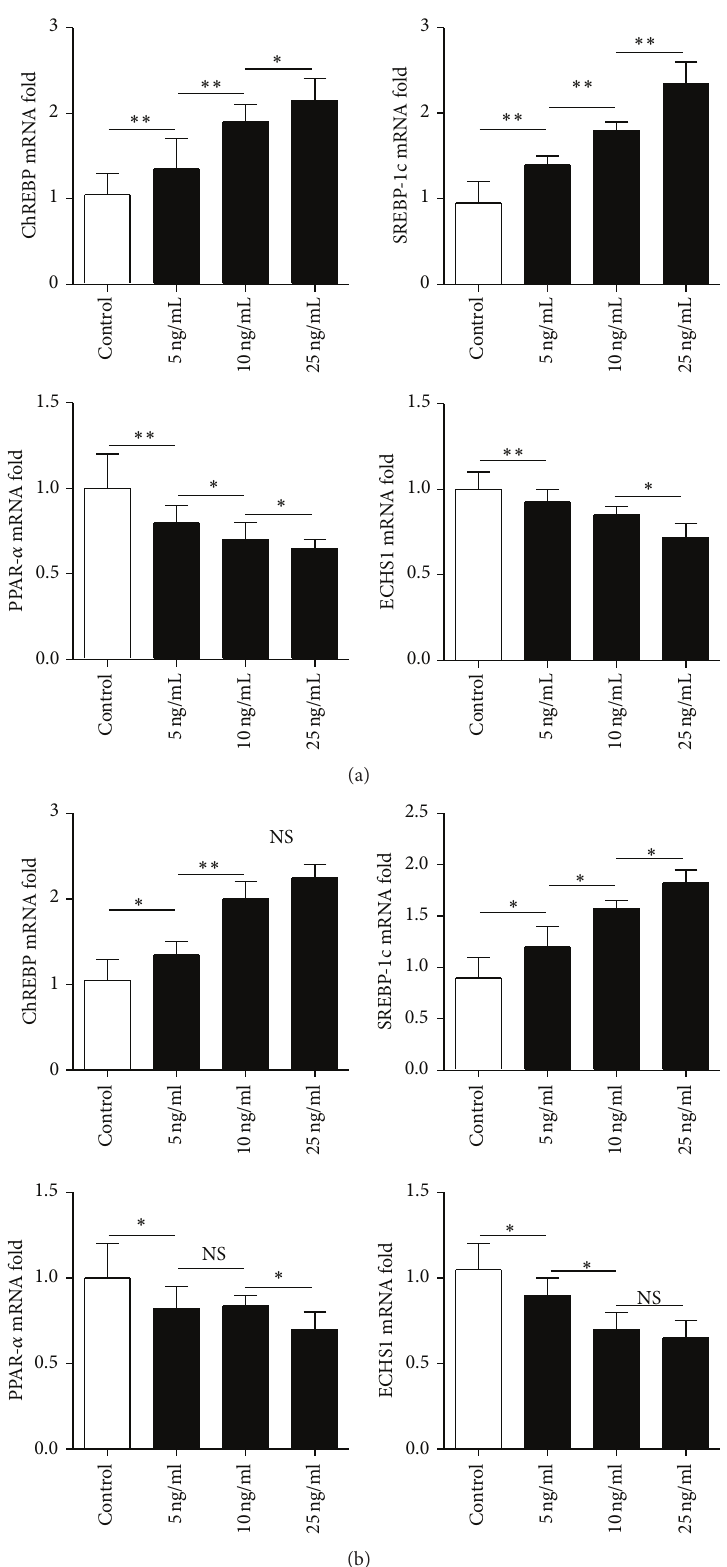
Figure 6: The effect of different serum levels of IL-17 in L02 cells (a) or in AML-12 cells (b) on the transcript levels for the four selected proteins. Gene expression levels in mice from the control group were set at 1. The data indicate Mean ± SEM of five separate experiments. ∗ 𝑃 < 0.05 ; ∗∗ 𝑃 < 0.01 ; NS: no